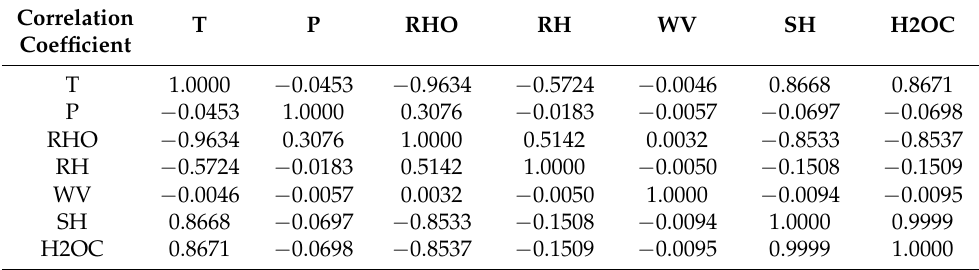
Table 1. Correlation coefficients between the parameters in the Jena dataset.